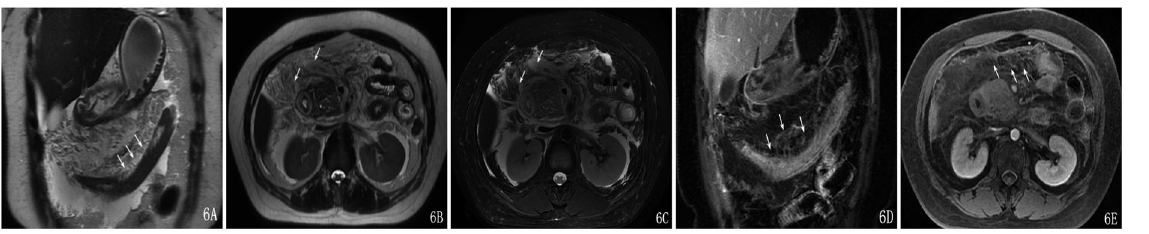
Figure 6. A 47-year-old female with severe AP and TMI was Grade III. The transverse mesocolon showed edema and thickening on a coronal SSFSE T2-weighted image (A). The transverse mesocolon showed effusions on an axial SSFSE T2-weighted image (B) and on an axial SSFSE T2- weighted image with fat suppression (C). The transverse-mesocolon-vessel involvement could be seen on the enhancement of the coronal image (D) and axial image (E).